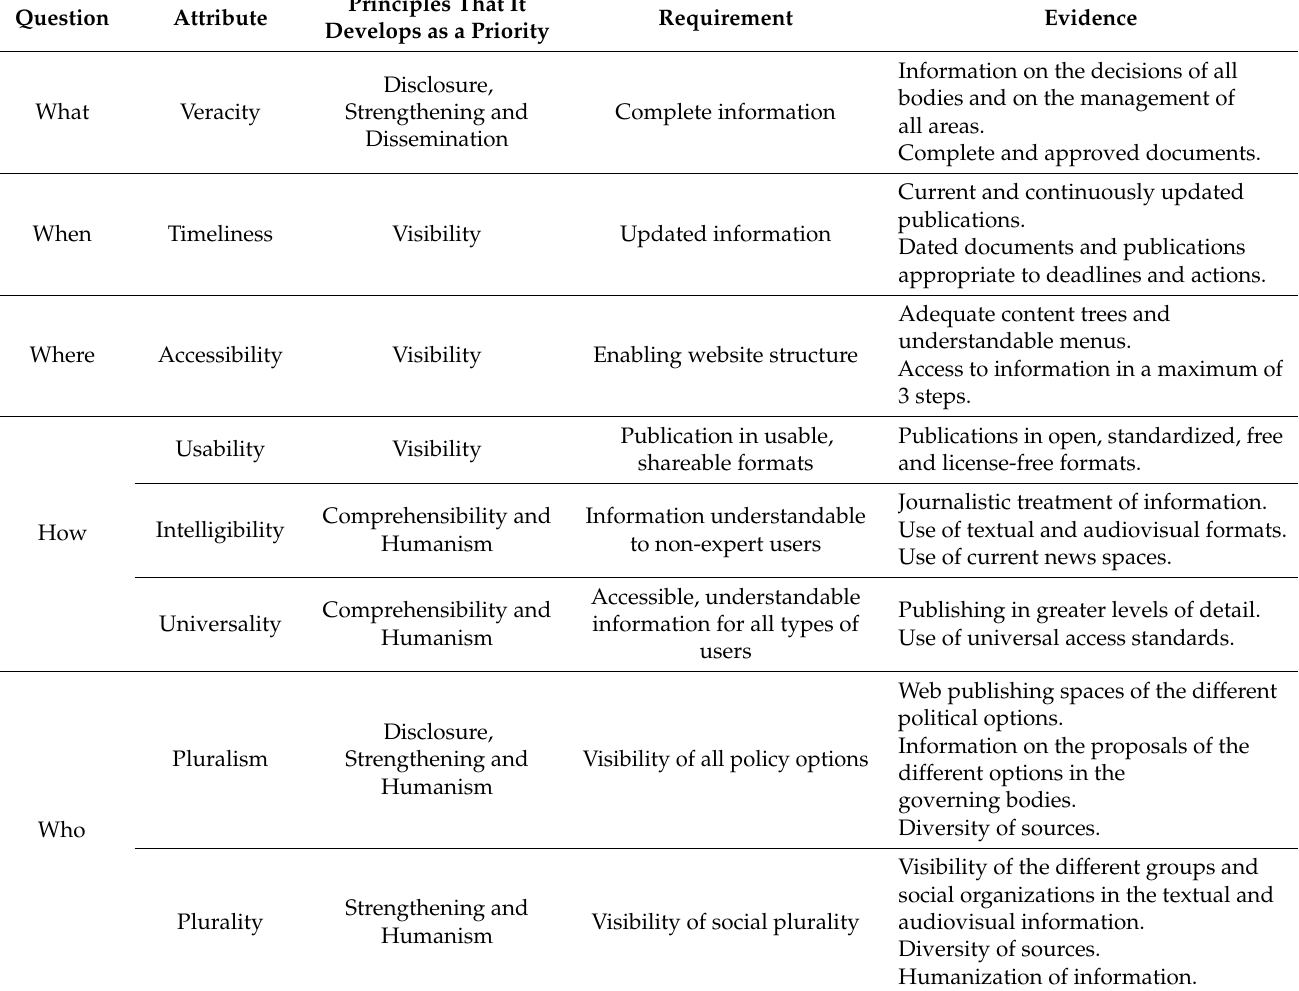
Table 3. Attributes of transparent